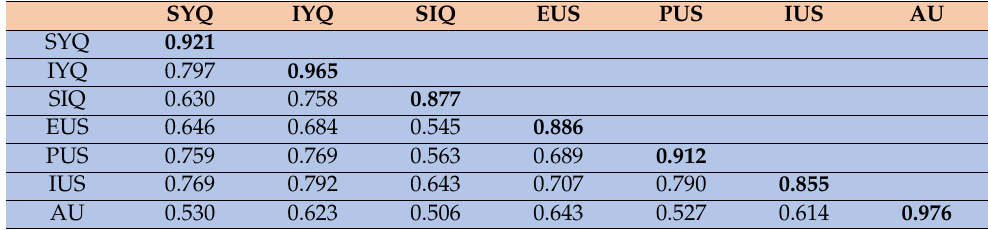
Table 5. Discriminant validity